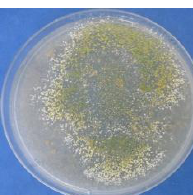
Figure 2. Enzymatic activities of Trichoderma isolates expressed on agar media supplemented with specific substrate. ( a ) Trichoderma pure cultures on PDA medium. ( b ) Colored zone generated by Trichoderma isolates for chitinase activity on medium supplemented with colloidal chitin. ( c ) Cellulase activity expressed on medium supplemented with carboxymethylcellulose CMC. ( d ) Keratinase activity expressed on specific medium.